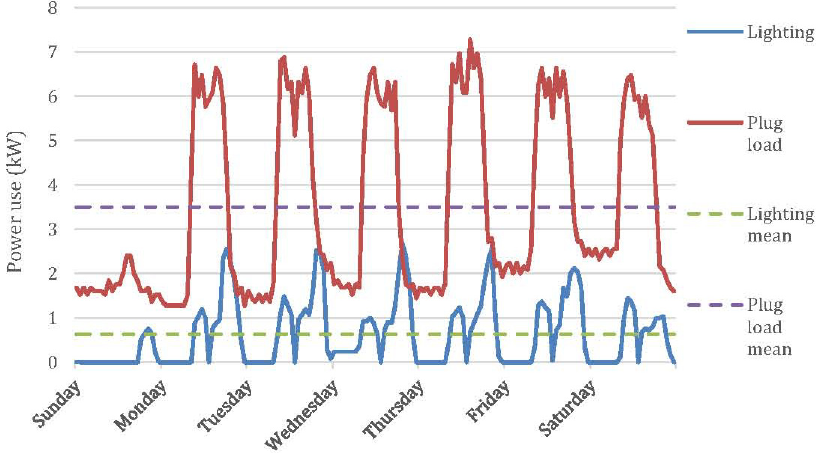
Figure 8. Power use for Plug Loads ( red ) and Lights ( blue ) for one week (1–7 August 2011) from the 8th floor offices of the IBR Building.